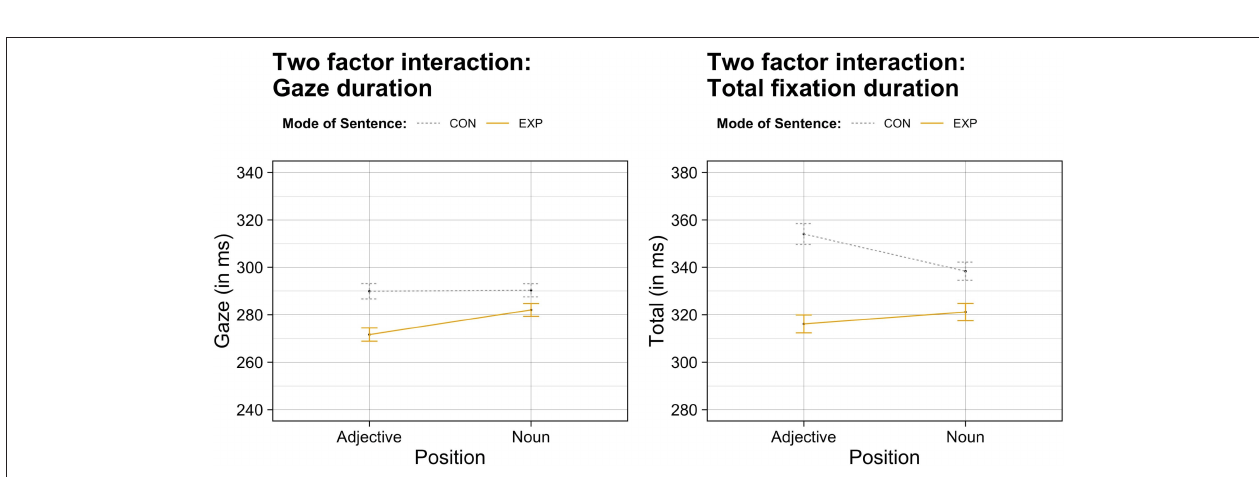
FIGURE 2 | Estimated values of the two factor interactions of SENTENCEMODE (EXP vs. CON) and POSITION (Adjective vs. Noun) (cf. Table 2 ) in Gaze duration (to the left, n.s.) and in the Total fixation duration (to the right); error bars represent the standard errors. The garden-path sentences (EXP, garden-path only in NoCap) are represented by yellow (solid) lines and the control sentences (CON) are represented by gray (dotted) lines.